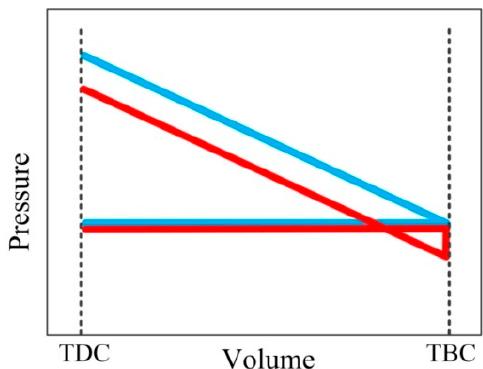
Figure 3. The schematic of in-cylinder pressure during the inactive cycle.